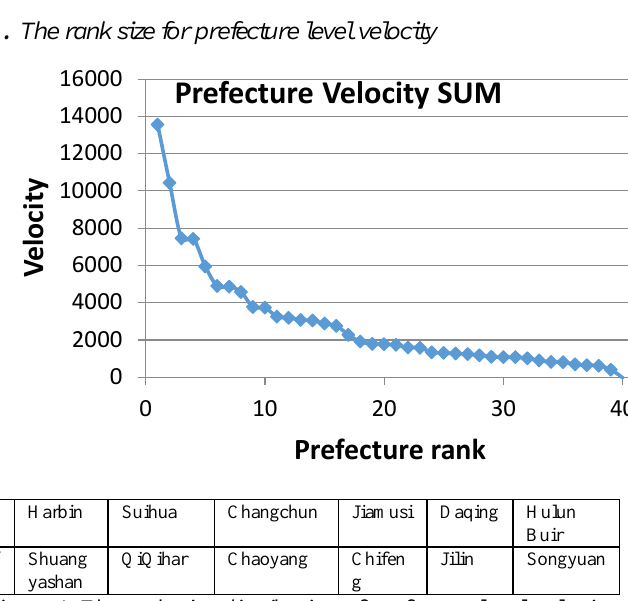
Figure 4. The rank size distribution of prefecture level velocity and the top 12